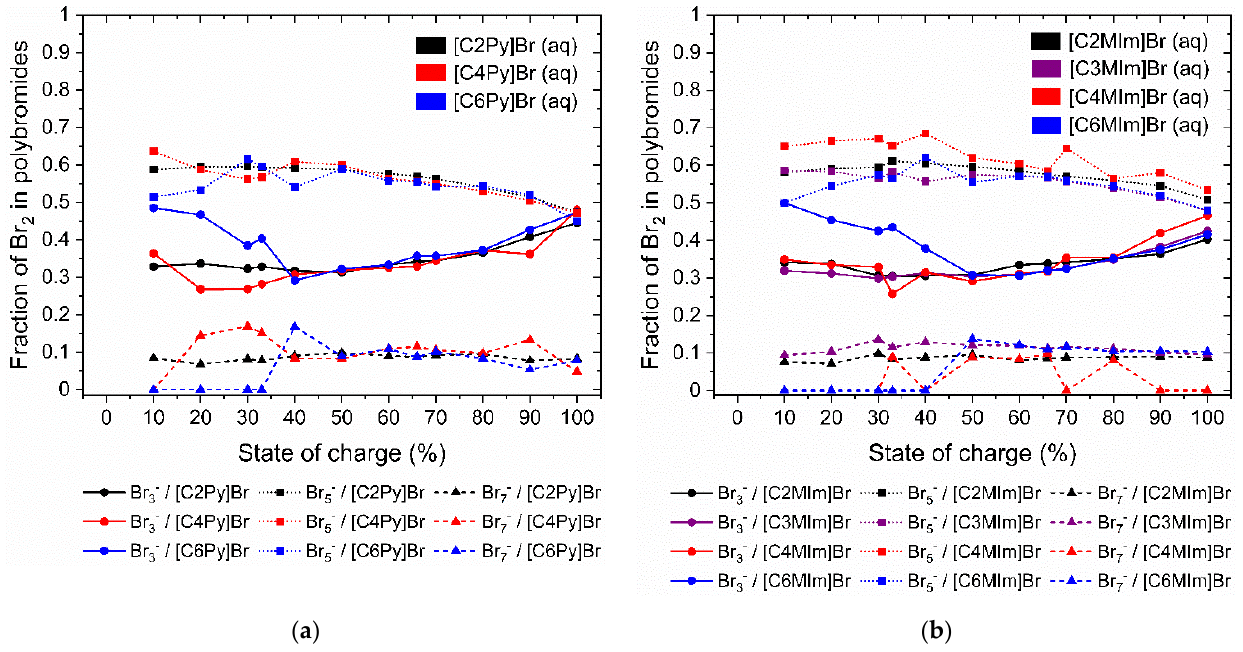
Figure 7. Distribution of Br 2 in the aqueous electrolyte phase on the polybromides Br 3- , Br 5- and Br 7- , which are present, depending on the SoC with different BCAs with different alkyl side chains in the N-position for ( a ) 1-alkylpyridine-1-ium bromides and ( b ) 1-alkyl-3-methylimidazole-1-ium bromides as BCAs at θ = 23 ± 1 °C. All values of Br 2 distribution on polybromides are printed in the SM in Tables S3, S4 and S5.